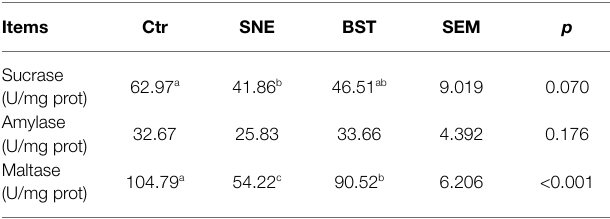
TABLE 5 | Duodenal mucosa biochemistry parameters of SNE broilers treatment with Bacillus subtilis DSM29784 (mean ± SEM, n = 8 per treatment). Items